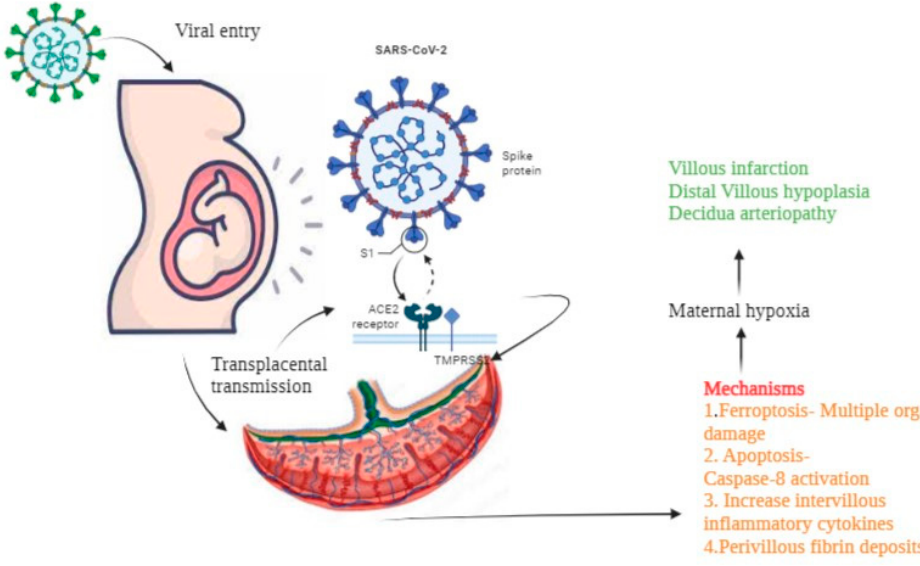
Figure 1. The influence of SAR-CoV-2 on placental development.